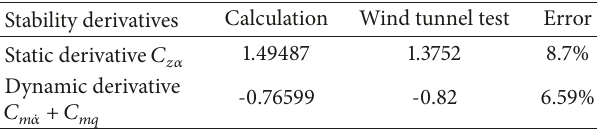
Table 2: Calculation results of static and dynamic